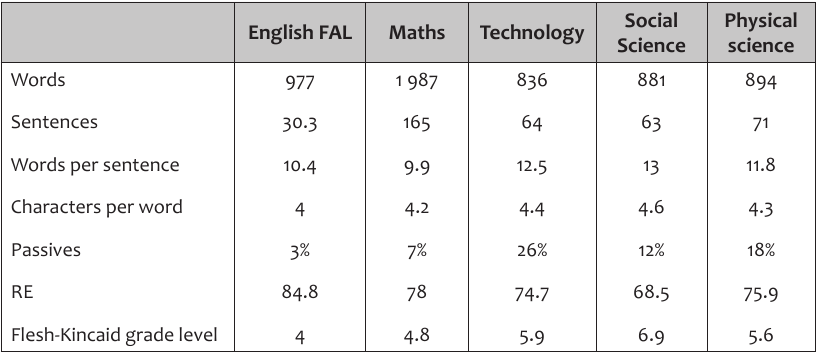
English 1 st Add Maths Life Skills Lang